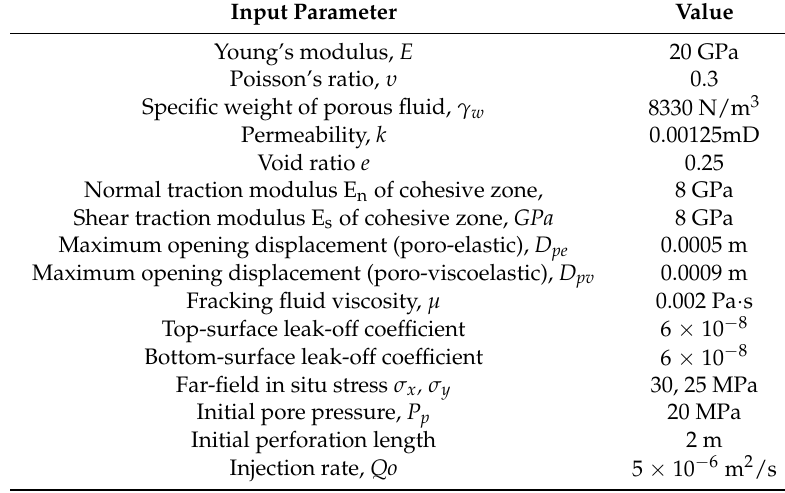
Table 1. All the parameters used in numerical